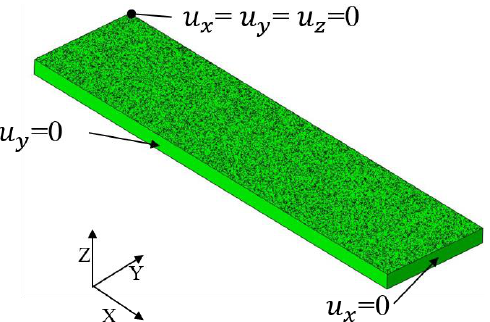
Figure 9. Springback implicit FEM for removal